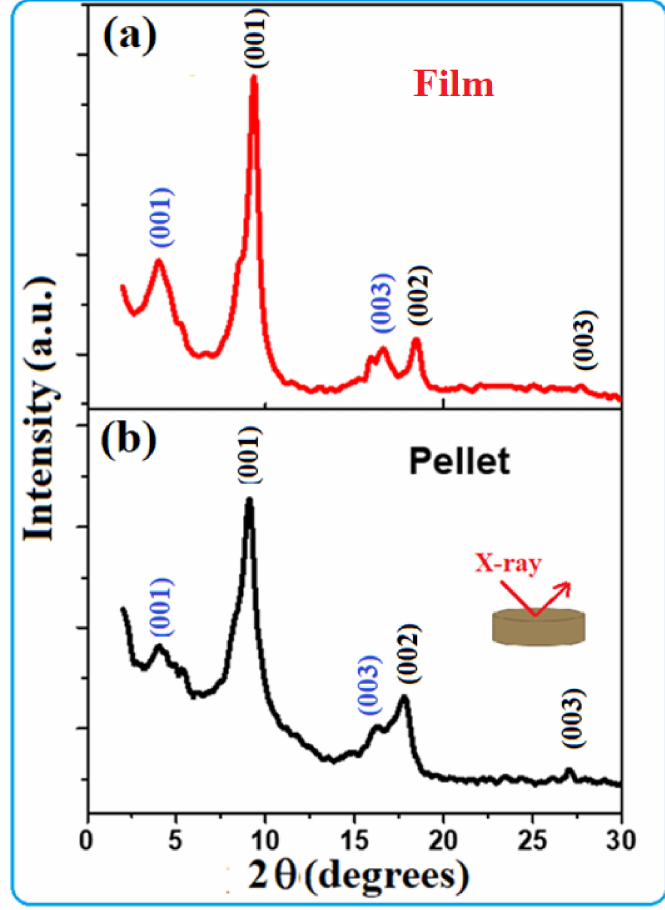
Figure 4. XRD patterns of TOS formed as ( a ) a film on a glass substrate, and ( b ) a pressed compact of the collected powder formed on the bottom of the petri dish without using a